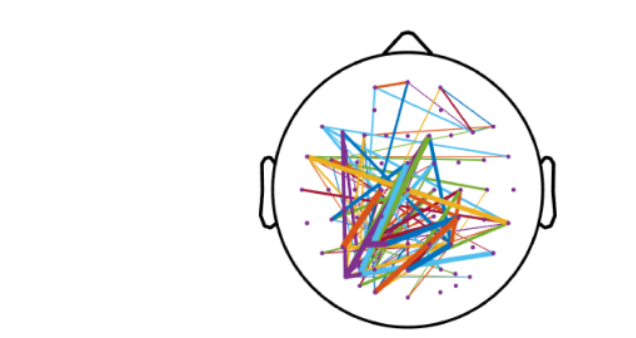
Figure 7. brain connectivity from − 1 to 3 s for stimulus A.